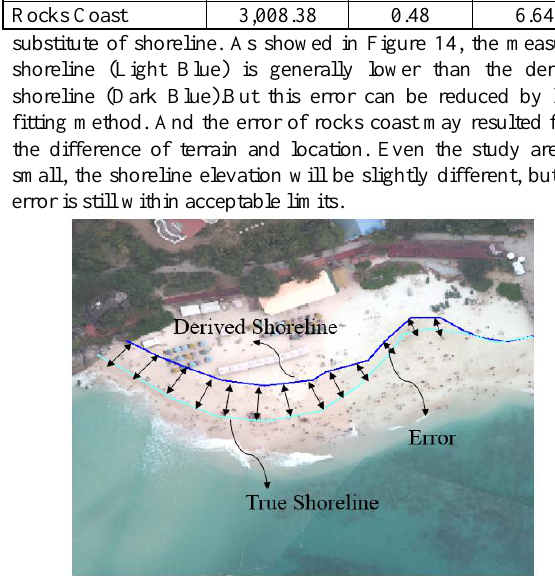
Figure 14 The region which have big